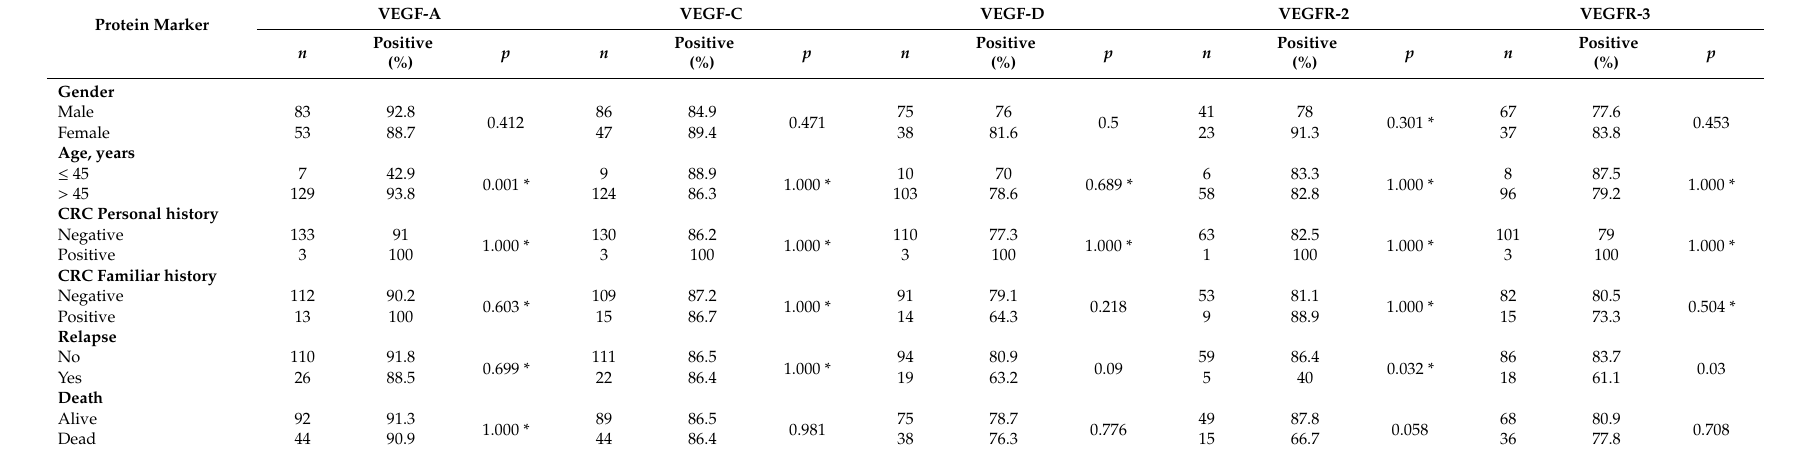
Table 3. Assessment of correlation between CRC lymph node metastasis VEGF-A, VEGF-C, VEGF-D, VEGFR-2 and VEGFR-3 expression and clinical data. * Examined for statistical significance using Fisher’s exact test (when n < 5). In bold the significant